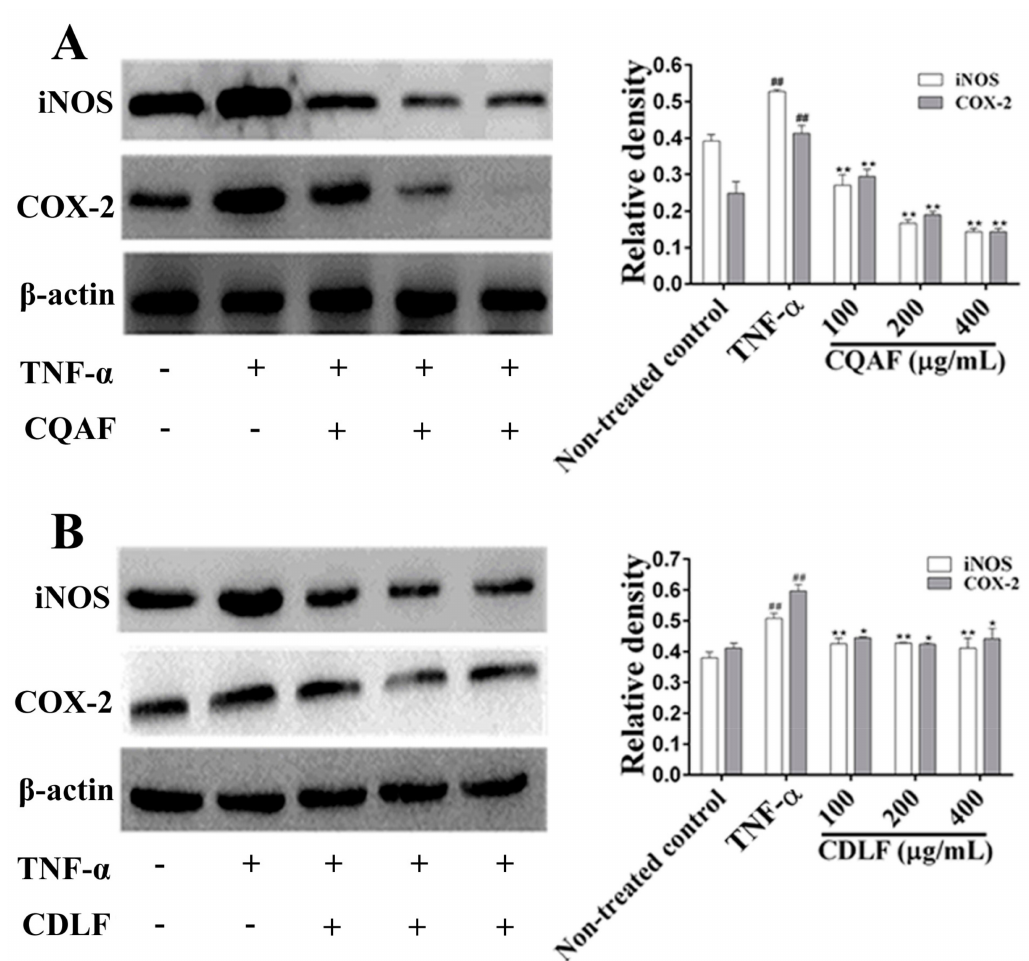
Figure 7. Effects of CDLF and CQAF on protein expressions of iNOS and COX-2 in MH7A